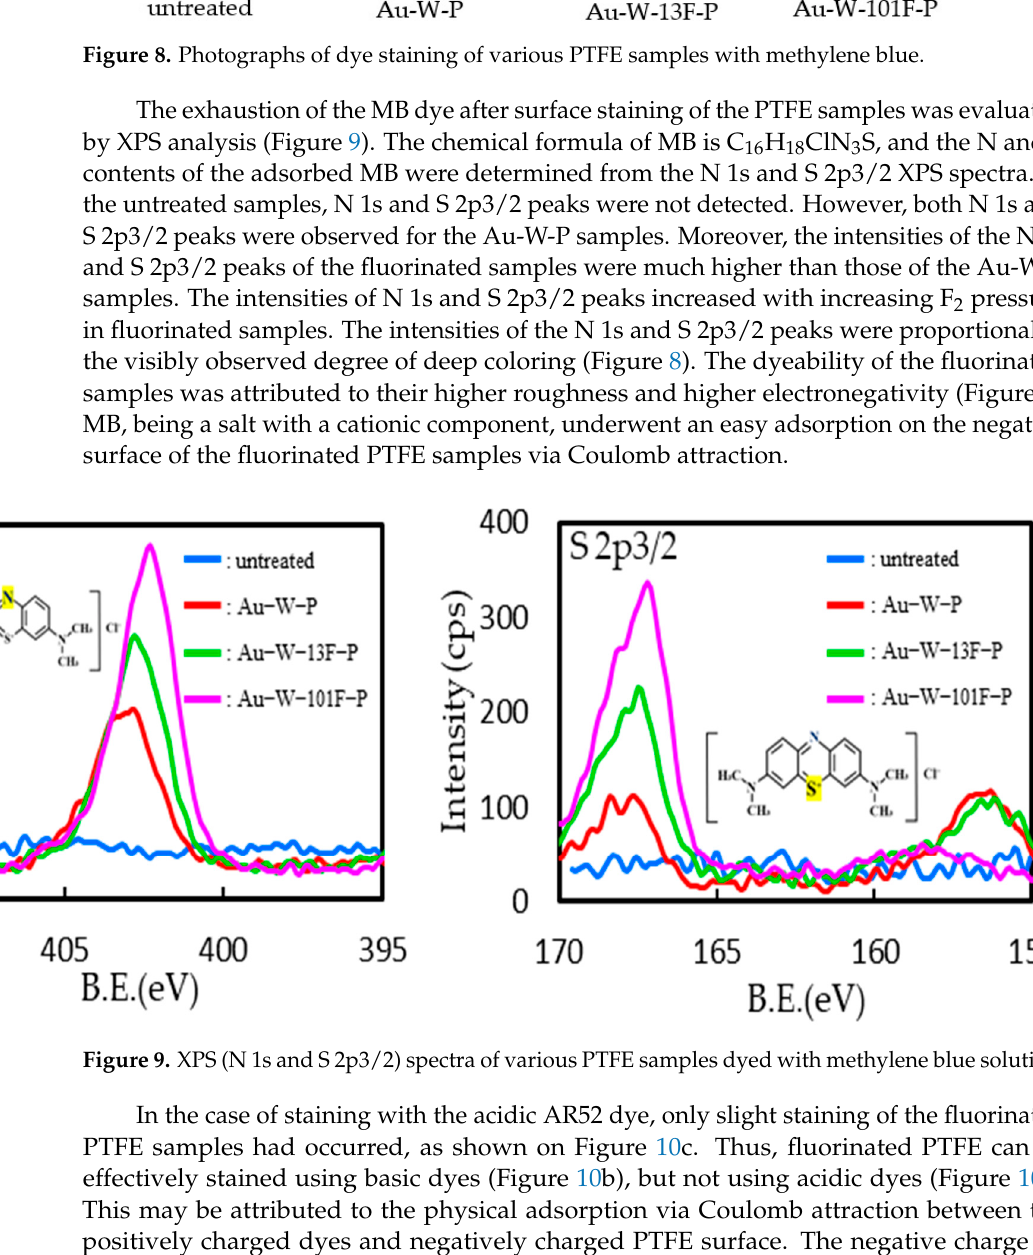
Figure 9. XPS (N 1s and S 2p3/2) spectra of various PTFE samples dyed with methylene blue solu-